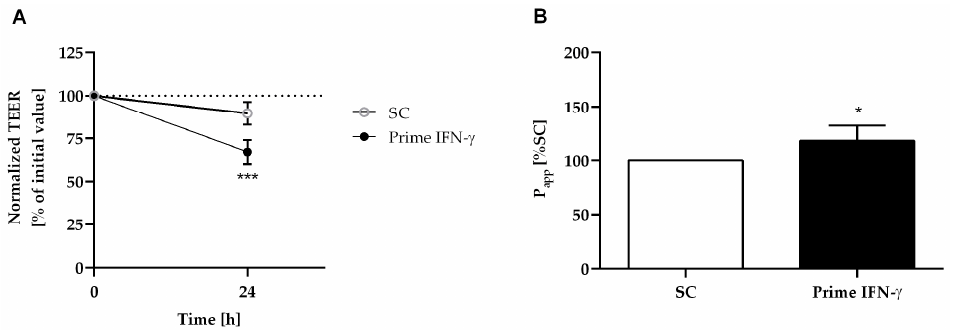
Figure 4. IFN- γ priming on the Caco-2/HT29-MTX-E12 co-culture. After 24 h incubation with 50 ng/mL IFN- γ , TEER ( A ) and permeability value (P app ) ( B ) of Caco-2/HT29-MTX-E12 co-cultures were measured. TEER values were expressed as a percentage of the initial TEER value (100%). Permeability was expressed as fold change of the untreated control (SC) used as a reference. Bars are the means ± SD ( n ≥ 3). * p < 0.05, or *** p < 0.001 were considered signi fi cantly di ff erent versus SC.